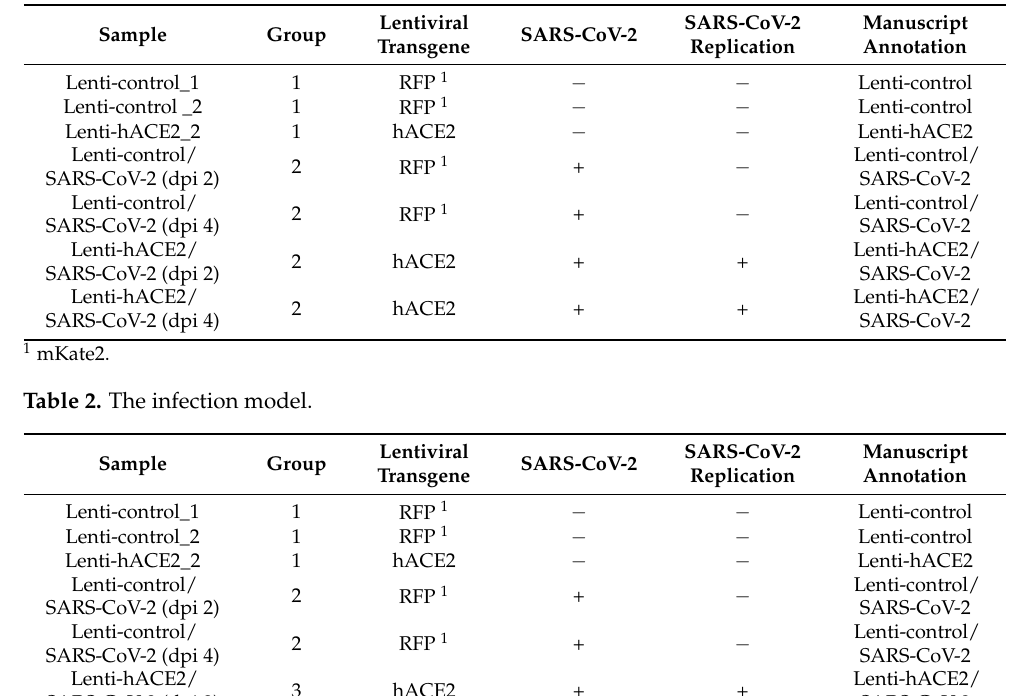
Table 1. The exposure model.